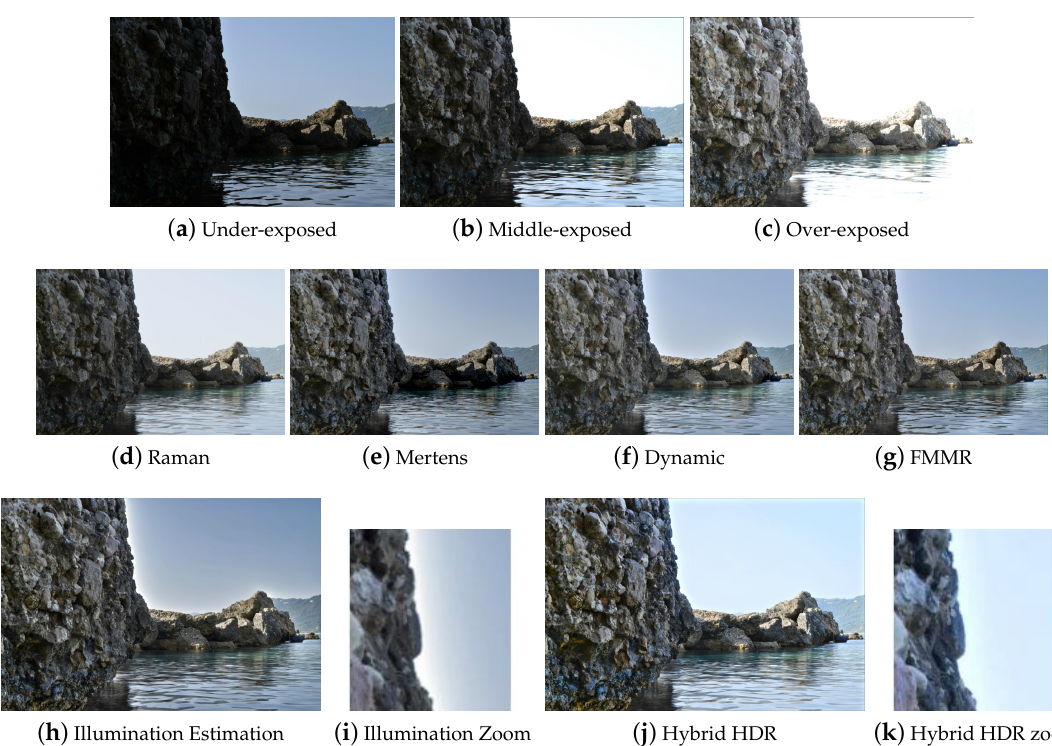
Figure 3. Comparison of the six MEF algorithms using the “SeaRock” images. Halo artifacts remain in the Illumination Estimation method, which are not visible in Hybrid